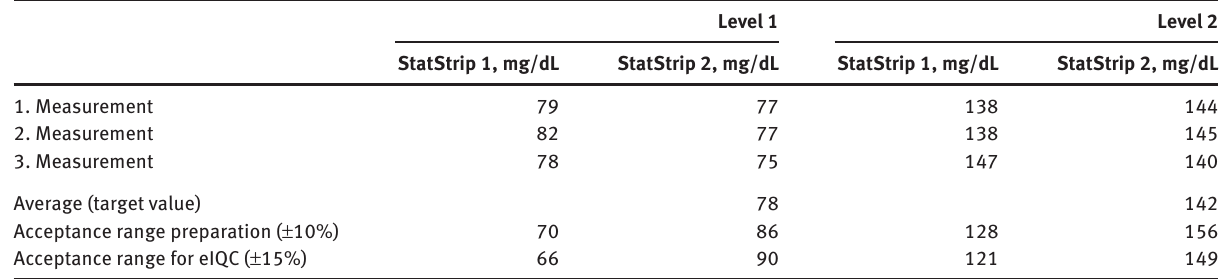
Table 1: Example of a setup measurement and calculation of target values and acceptance ranges for an eIQC on two POCT devices (StatStrip 1 and StatStrip